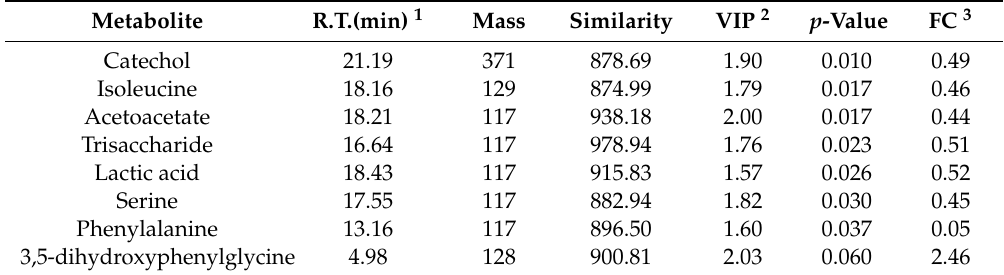
Table 9. List of significantly changed metabolites between the Con group and the MT